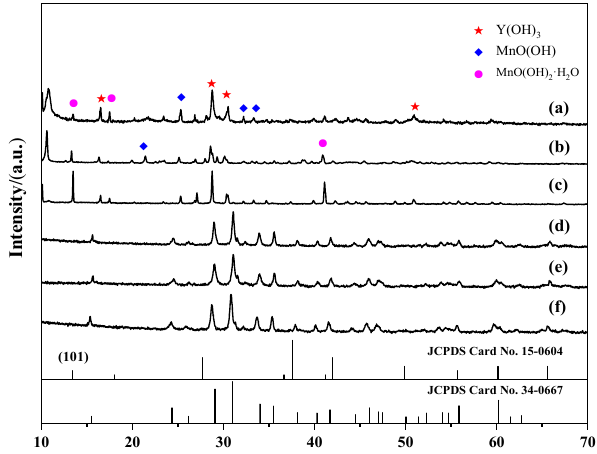
Figure 4. XRD patterns of samples synthesized at different hydrothermal temperatures: ( a ) 140 °C; ( b ) 160 °C; ( c ) 170 °C; ( d ) 180 °C; ( e ) 200 °C; ( f ) 220 °C.